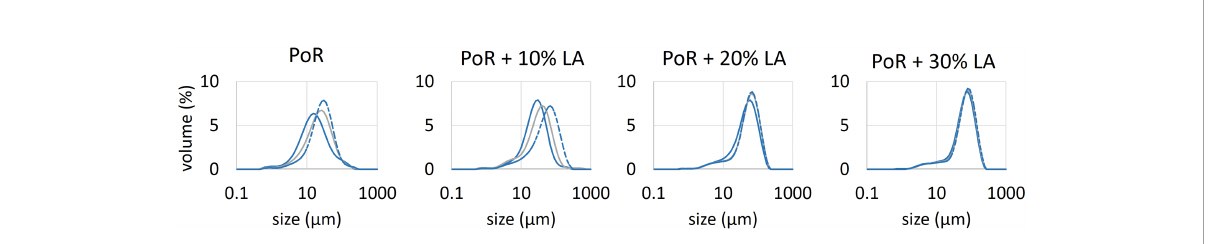
FIGURE 7 Particle size distributions as function of time. Full blue curve: after injection of algae; grey curve: 500 s after injection; dashed blue curve: before sampling for LabSFLOC2 measurements (when steady-state is